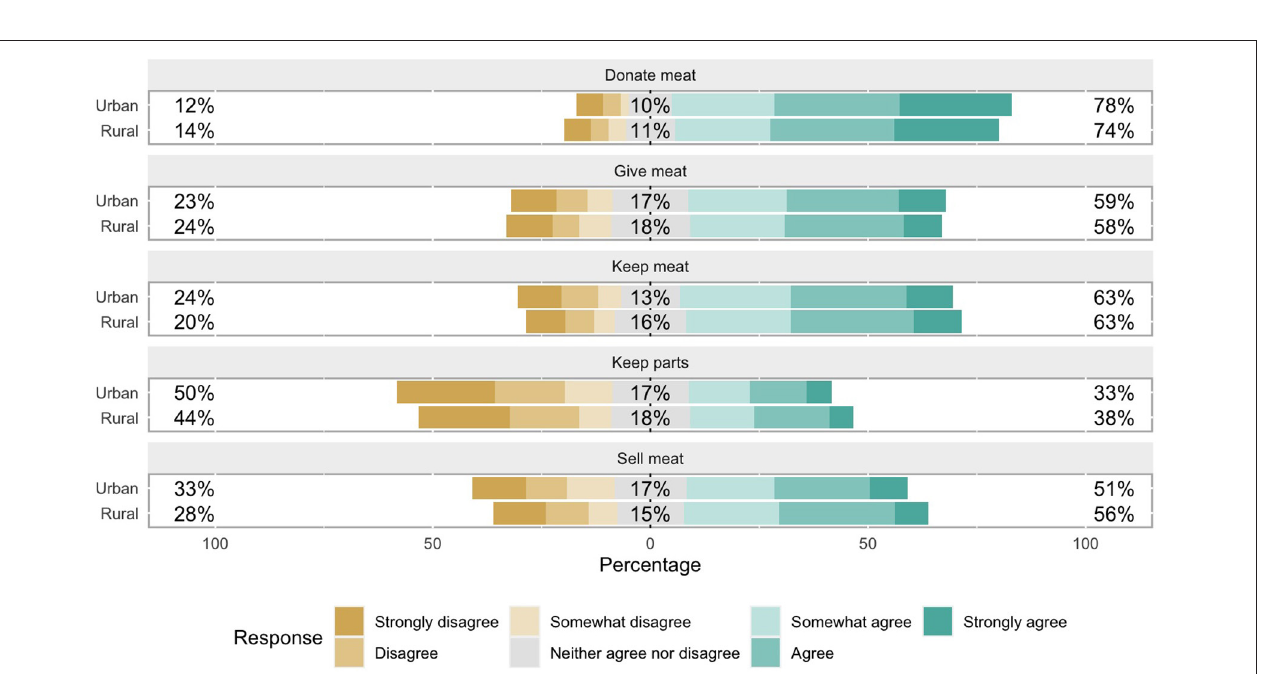
FIGURE 4 | Importance of people who shoot deer having certain characteristics, split by urban and rural respondents. Bars show distribution of responses, colored by disagreement (browns), indifference (gray), and agreement (greens). Percentages show proportions of respondents who disagreed (left), were indifferent (middle), or agreed (right) that each characteristic was important, after excluding “I don’t know” responses.